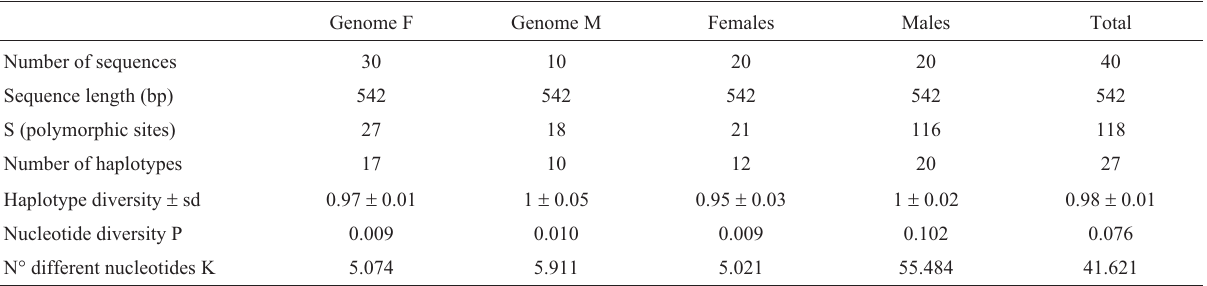
Table 2 - Indices of genetic variability based on mtDNA (COI) sequences for F and M genome, females and males (gonadic and somatic tissues together) and total in the mussel P.